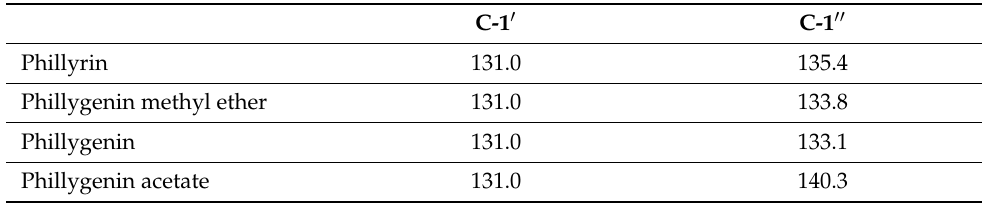
Table 1. Chemical shifts for C- 1′ and C- 1” of phillyrin and phillygenin derivatives.